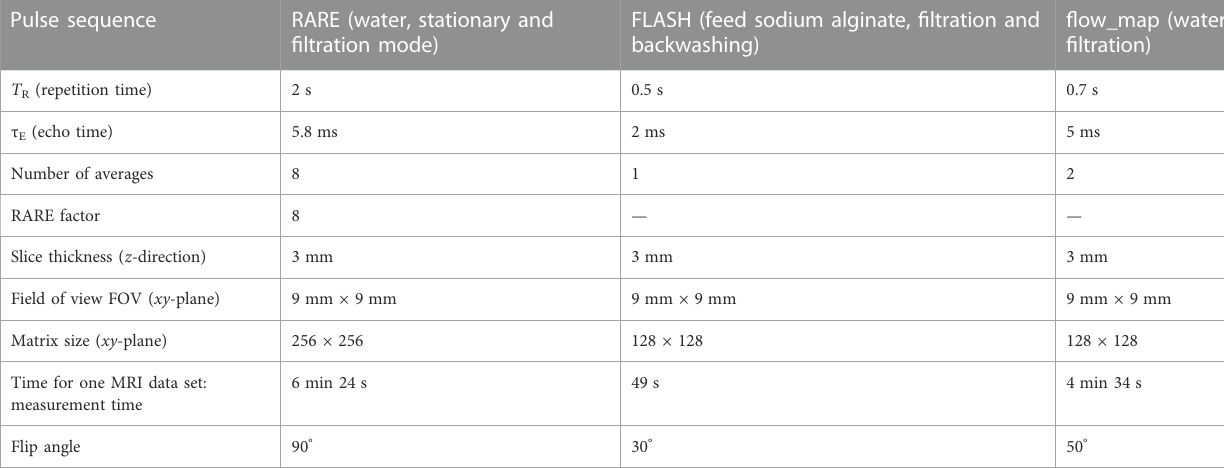
TABLE 1 MRI parameters for structural and fl ow MRI. Pulse sequence RARE (water, stationary and FLASH (feed sodium alginate, fi ltration and fi ltration mode)